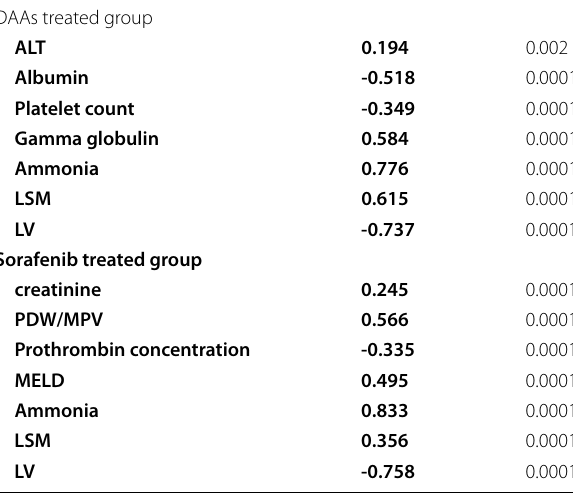
Table 4 variables correlated with occurrence of complications in the studied